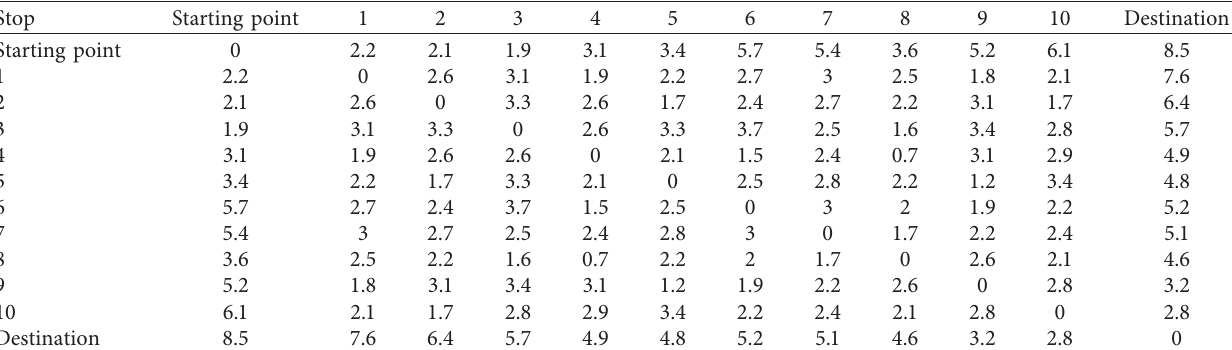
Table 3: Distances between stops (km).